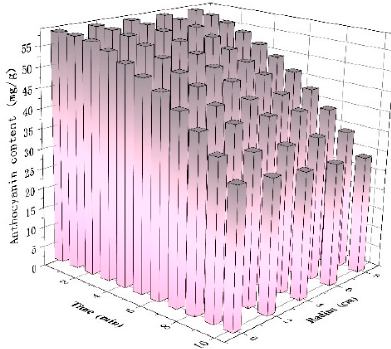
Figure 6. The distribution of anthocyanin content in berry pure at the microwave intensity of 8 W/g.